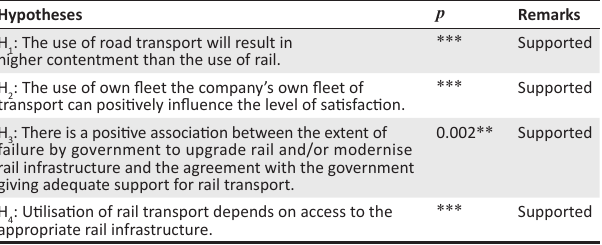
TABLE 3: Hypotheses tests results.